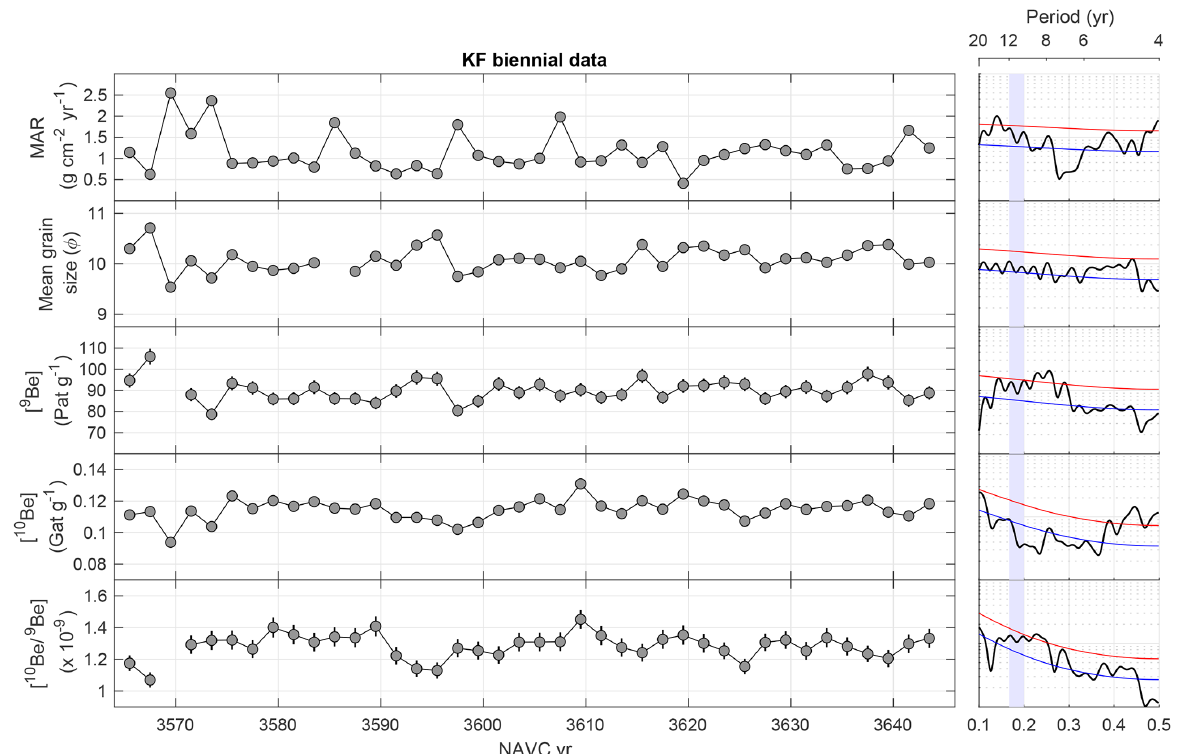
Figure 12. Sedimentological data and Be concentrations for 80-year record with 2-year resolution from glacial varves at Kelsey–Ferguson (KF) site, with MTM spectra. Plot elements are the same as described in Fig. 11. For the purposes of spectral analysis, missing grain size and 10 Be data for two samples were filled by linear interpolation between adjacent